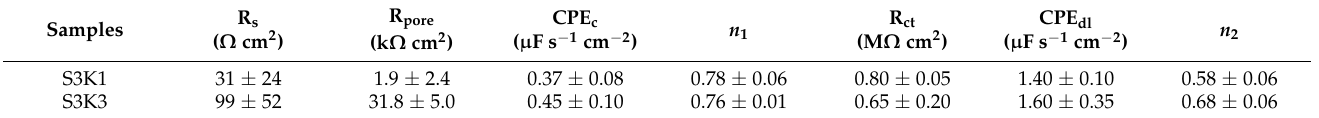
Table 4. Fitting results of EIS analysis for the PEO coatings prepared from the coating solutions containing different concentrations of KOH after 24 h immersion in 3.5 wt.% NaCl solution at pH 4.